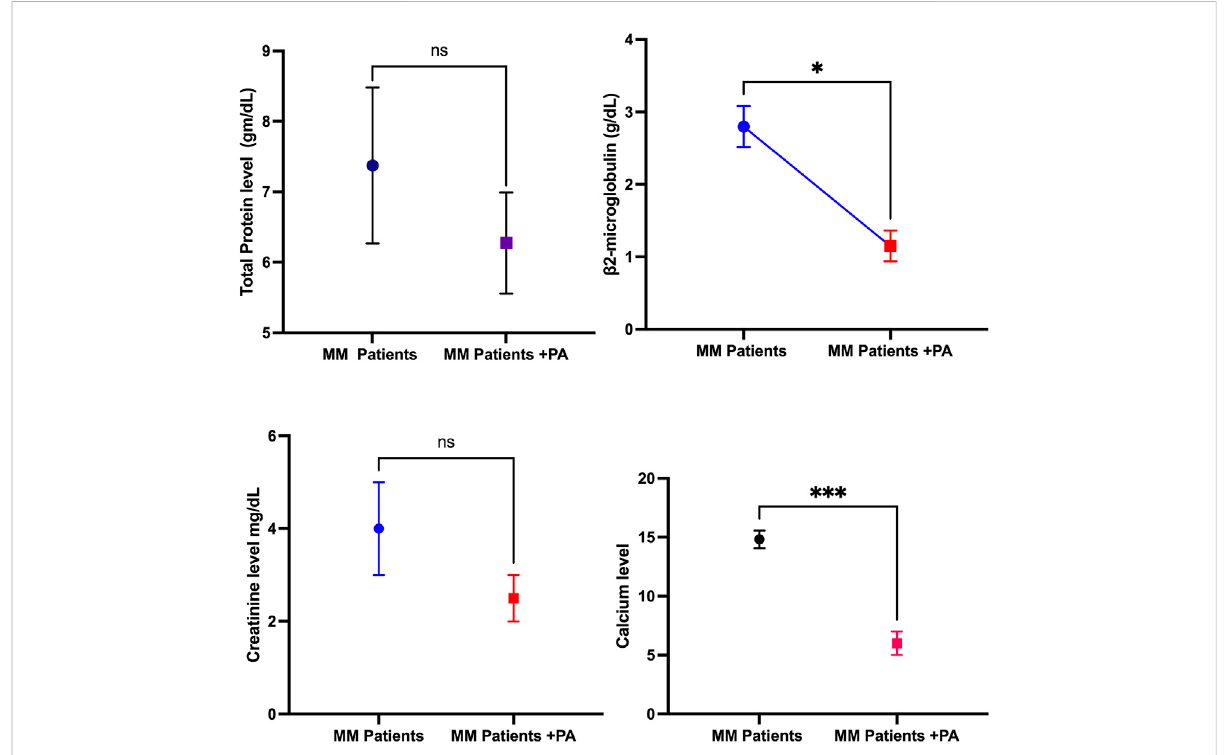
FIGURE 1 Effects of physical activity with MM on biochemical parameters such as total protein, β 2-microglobulin, creatinine level, and calcium level.